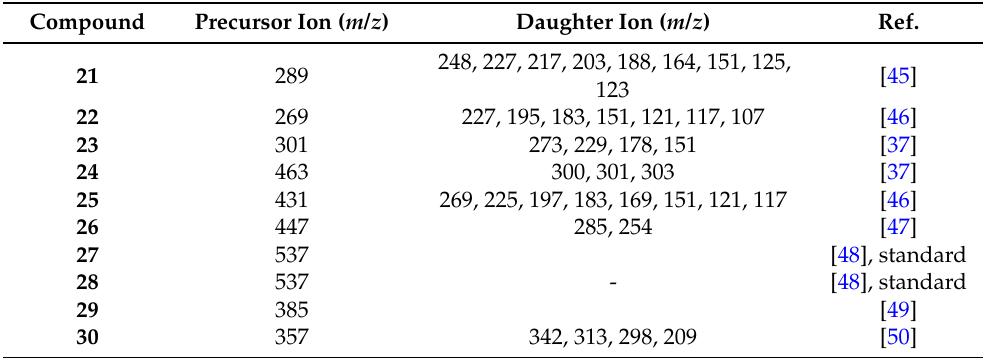
Table A4. LC-MS product ions compounds 21 – 30